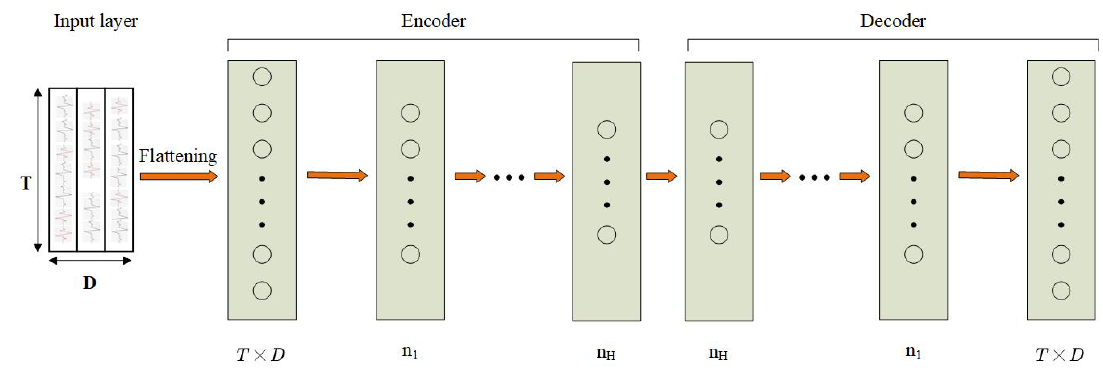
Figure 2. Architecture of an autoencoders (AE) approach for HAR. T in the input layer denotes the length of the time window. D denotes the number of sensor channels. H denotes the number of hidden